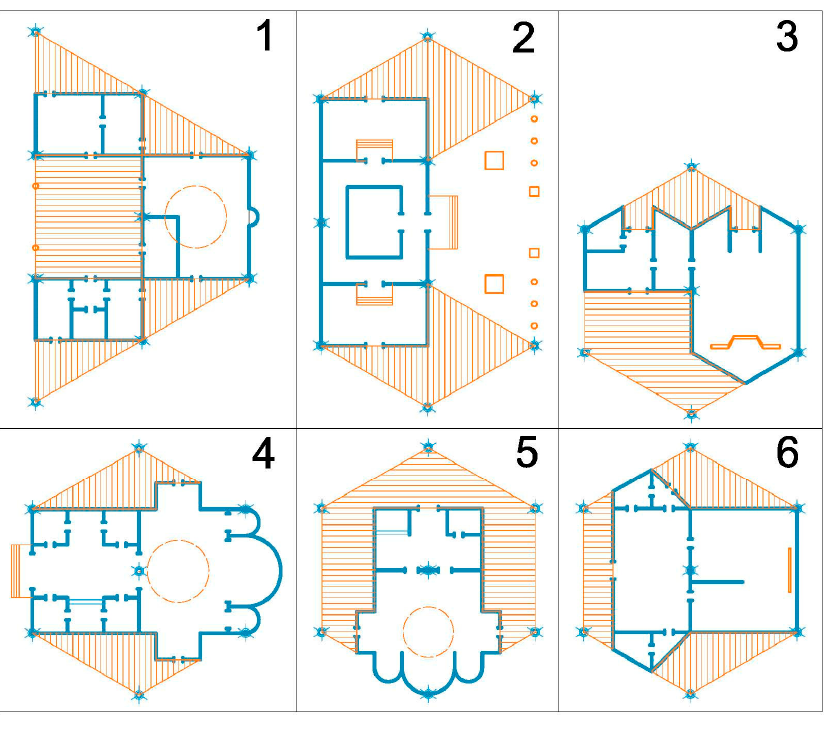
Figure 15. Planning solutions: 1—the Mosque; 2—the Buddhist temple; 3—the Protestant temple; 4—the Orthodox temple; 5—the Catholic temple; 6—the Synagogue.